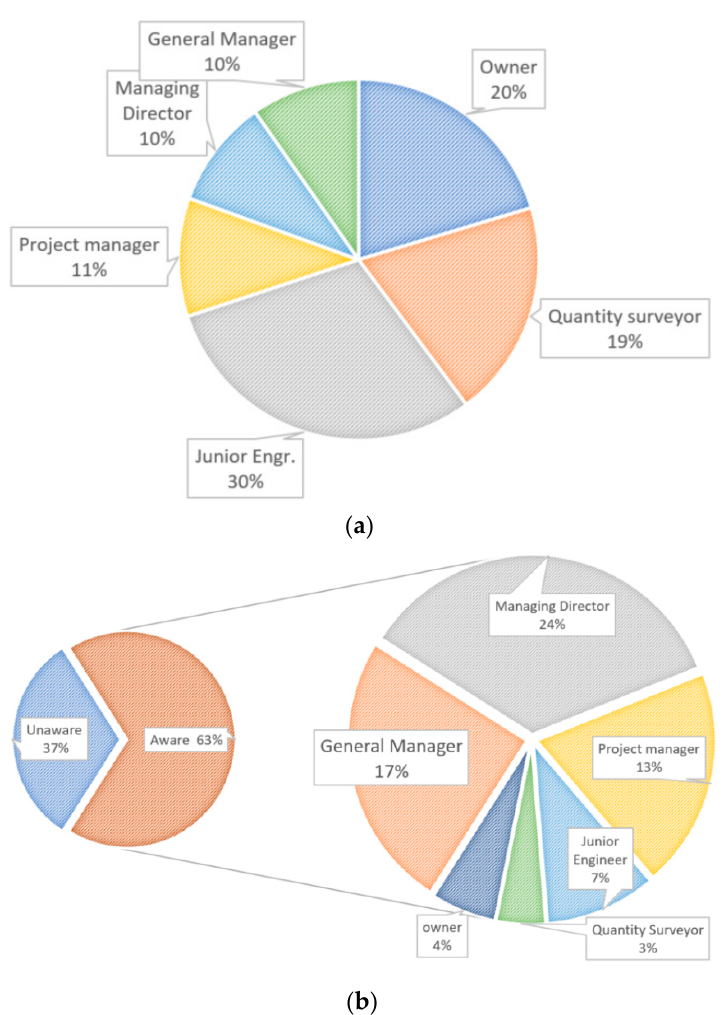
Figure 3. Respondents demographic profile; ( a ) post, ( b ) BIM awareness.